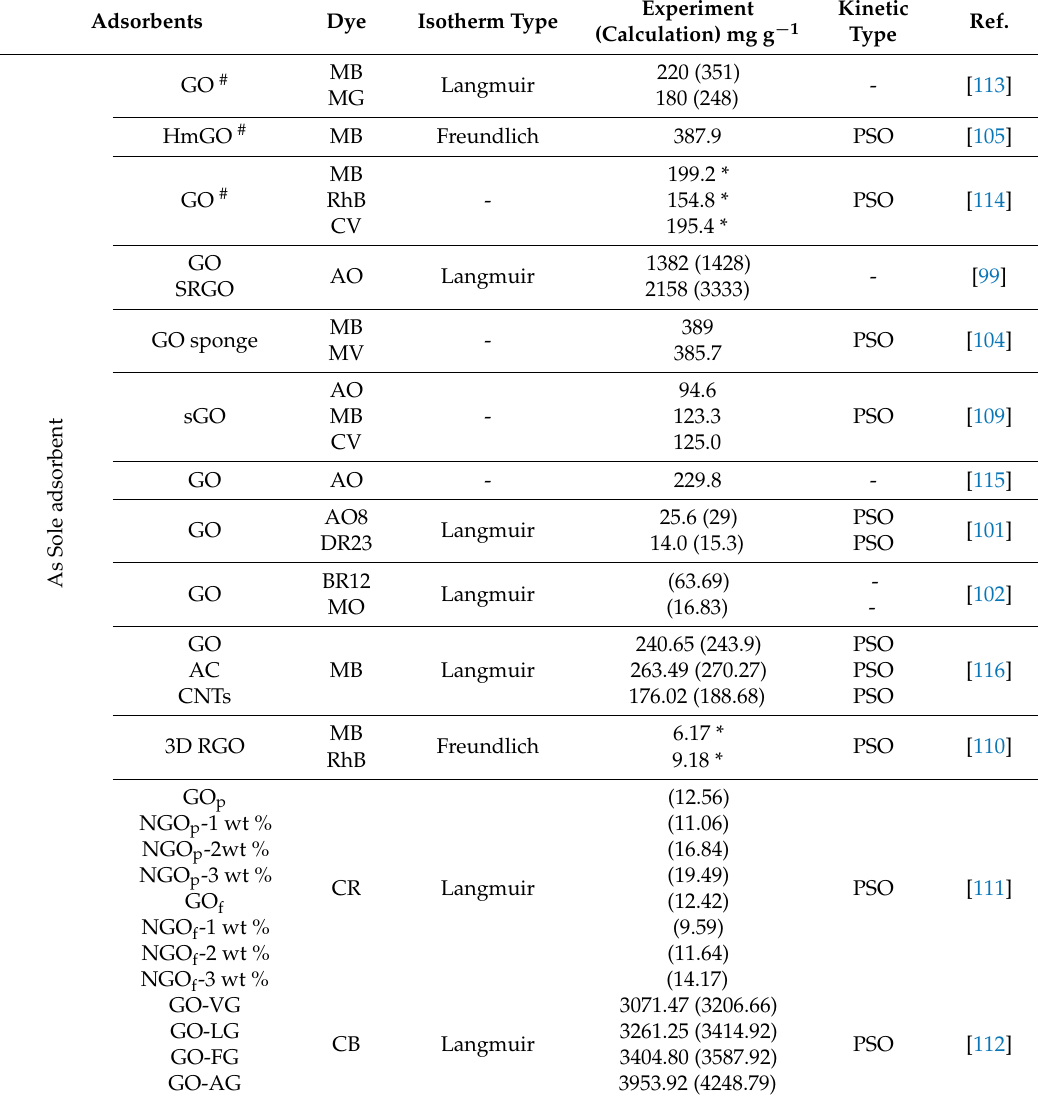
Table 2. A summary of dye removal by GO